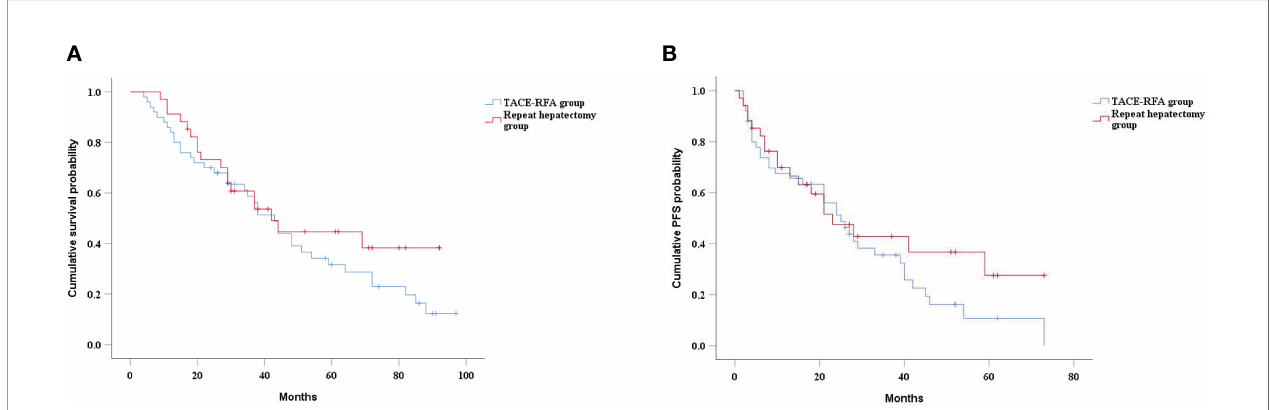
FIGURE 4 | Kaplan-Meier curves of cumulative survival (A) and PFS (B) in in patients with tumors smaller than 5cm in